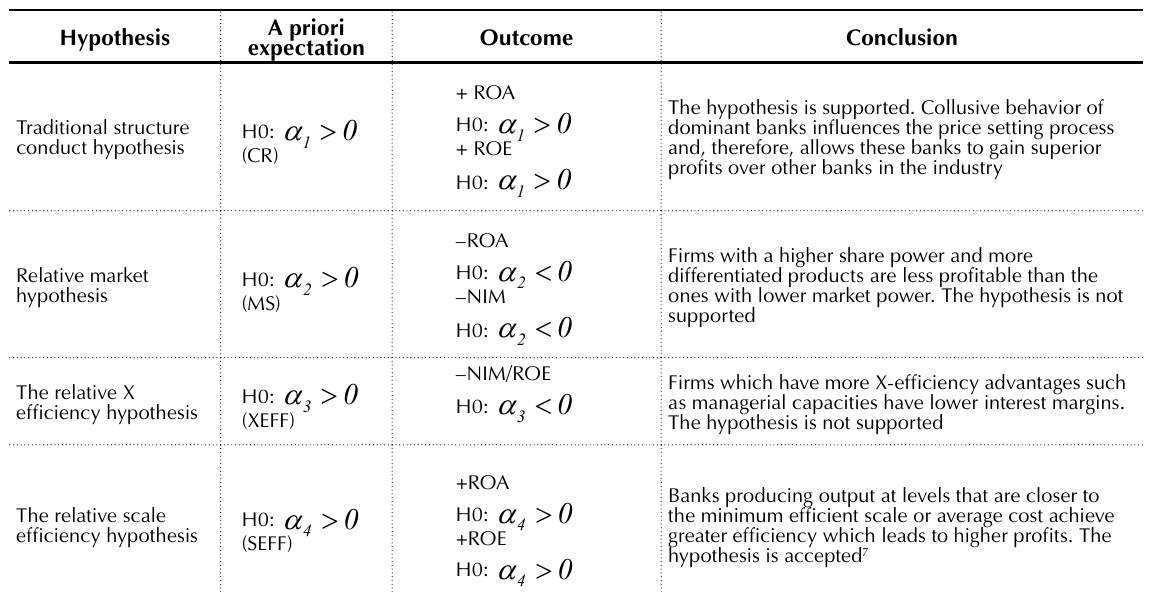
Table 4. Hypotheses